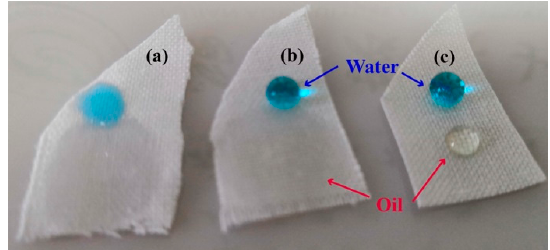
Figure 6. Oil droplet on pristine ( a ), PMHS-modified ( b ) and 1H,1H,2H-perfluoro-1-decene-modified ( c ) cotton fabrics.